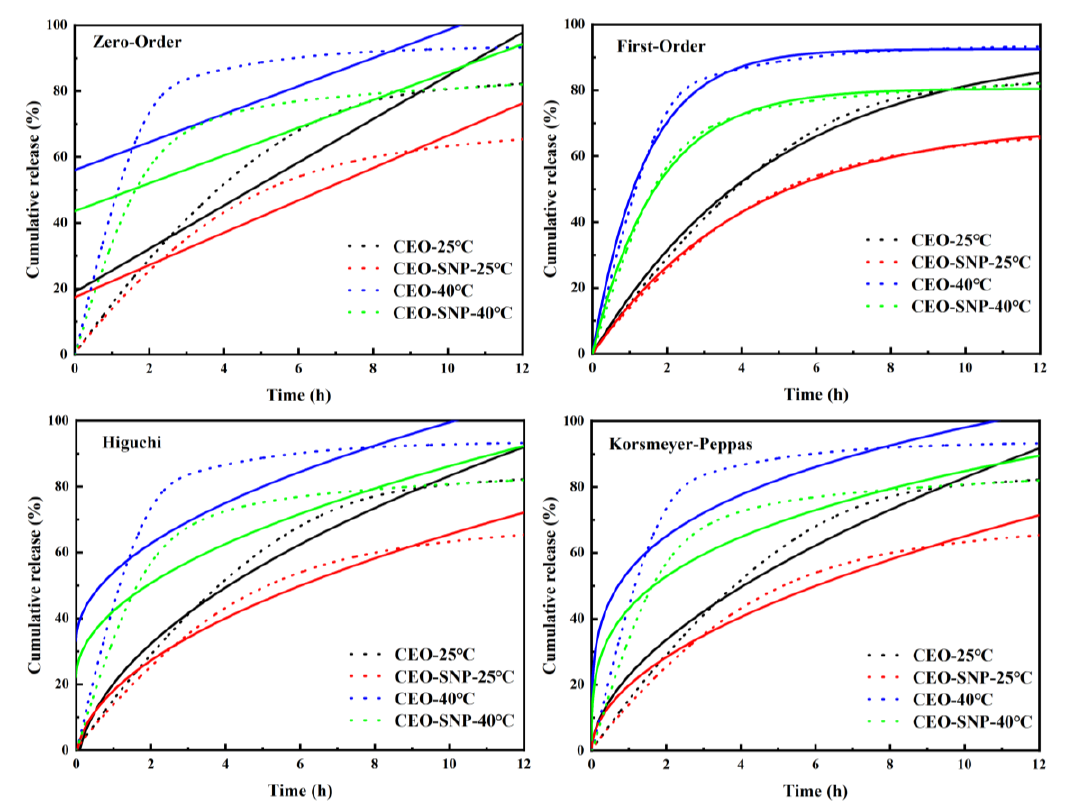
Figure 5. Model fitting curves of CEO, CEO−SNP at 25 and 40 °C. The dashed line represented the original experimental data and the straight line represented the fitting curve. Table 2. The Fitting Kinetic models for release be haviors of (a) CEO, (b) CEO−SNP.